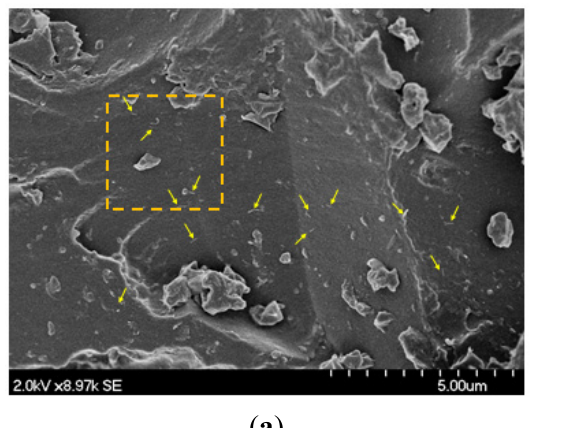
Figure 2. SEM image showing the dispersion of 1.0 wt% COOH-MWCNTs in the epoxy matrix. ( a ) The general view with the marked area shown at high resolution in ( b ); ( b ) the high resolution view of COOH-MWCNTs in epoxy showing individual carbon